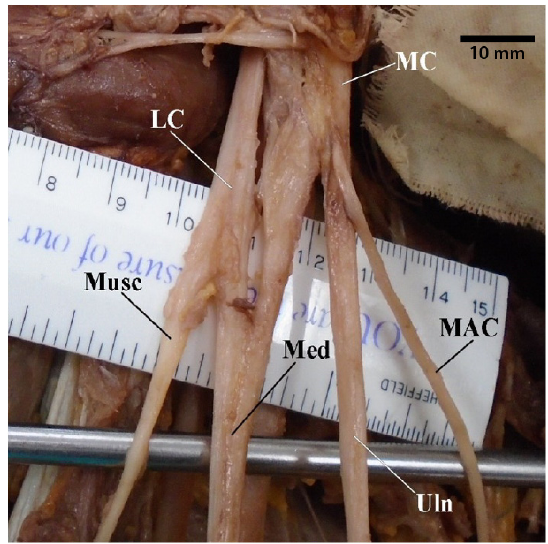
Figure 2. Photograph of a variant in which the brachial plexus “M” is asymmetrical but presents otherwise with its typical contributions and branches. Abbreviations: LC = lateral cord; MAC = medial antebrachial cutaneous nerve; MC = medial cord; Med = median nerve; Musc = musculocutaneous nerve; Uln = ulnar nerve.